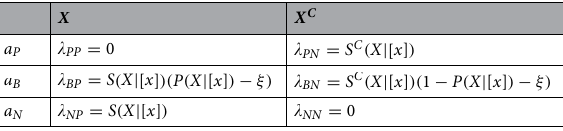
Table 1. Loss function